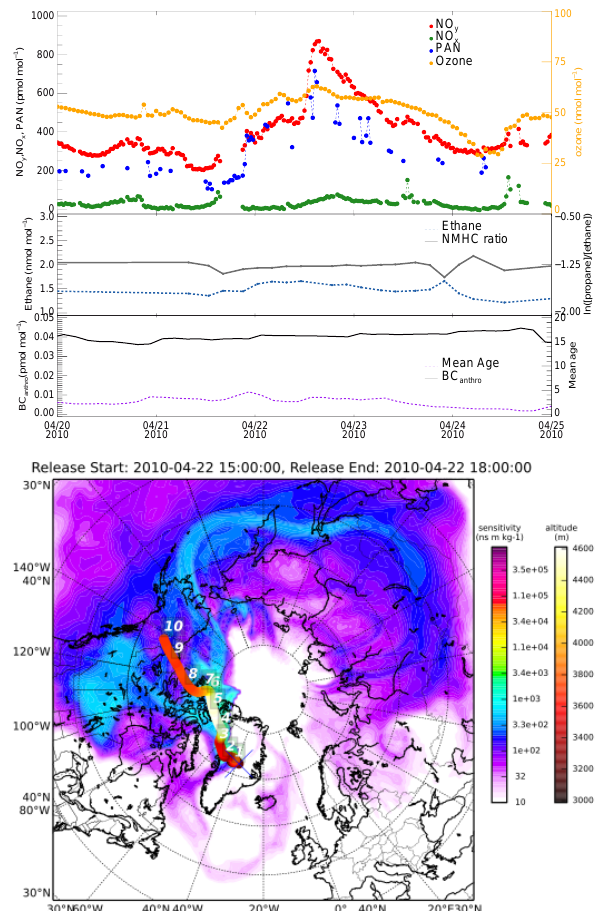
Figure 9. Top panel: 30min averages of NO x , NO y , PAN, 1h av- erage of O 3 , C 2 H 6 , ln ( [ propane ] / [ ethane ] , and FLEXPART BC fire tracer and mean weighted age at Summit from 20 to 25 April 2010. The vertical lines represent the arrival time of the FLEXPART simu- lated total column sensitivity at Summit on 22 April 2010, between 15:00 and 18:00UTC, as shown in the bottom panel.